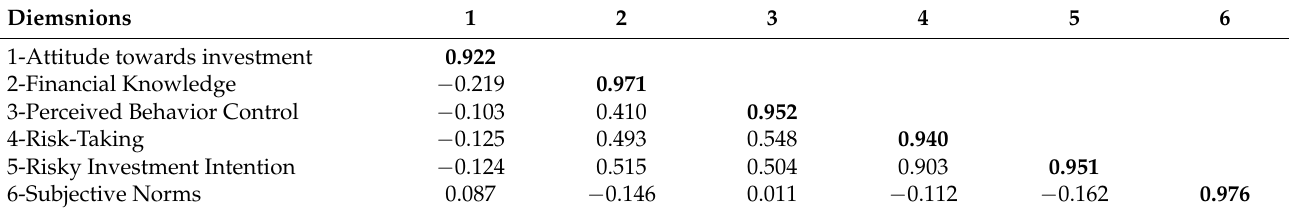
Table 4. Fornell-Larcker